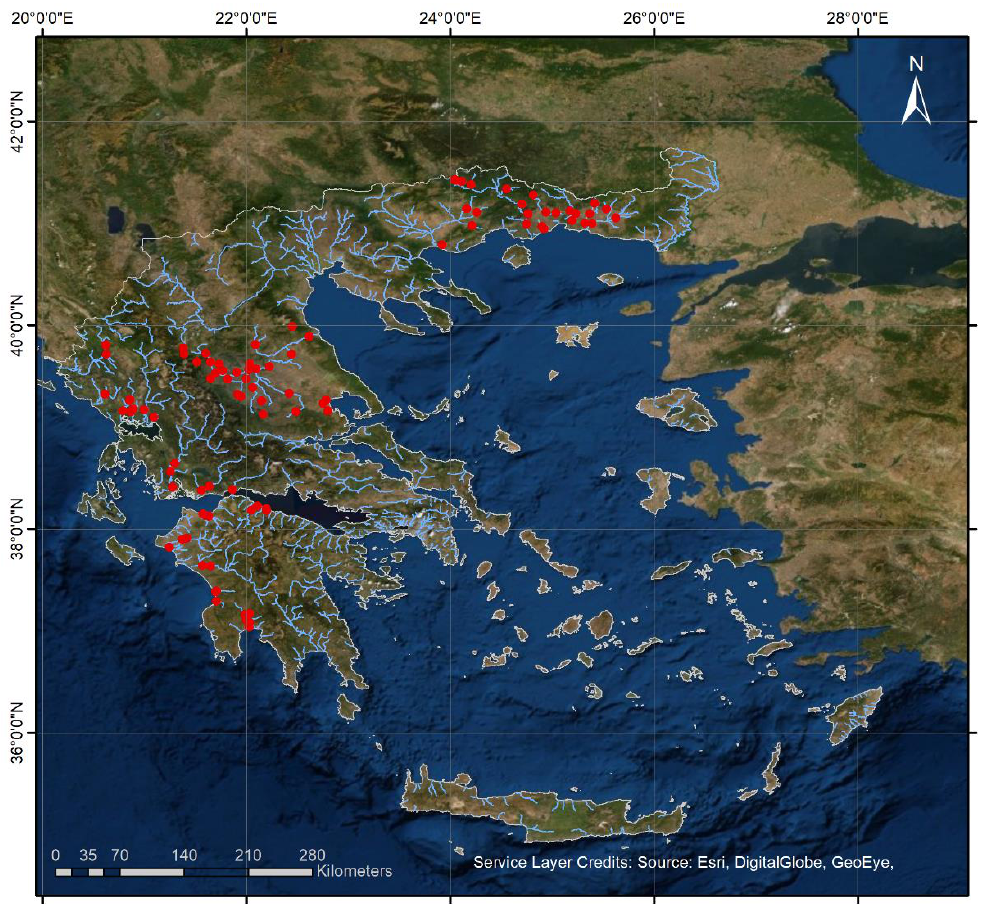
Figure 1. Location of sampling sites ( n = 93) of the National Monitoring network, across streams and rivers of mainland Greece.